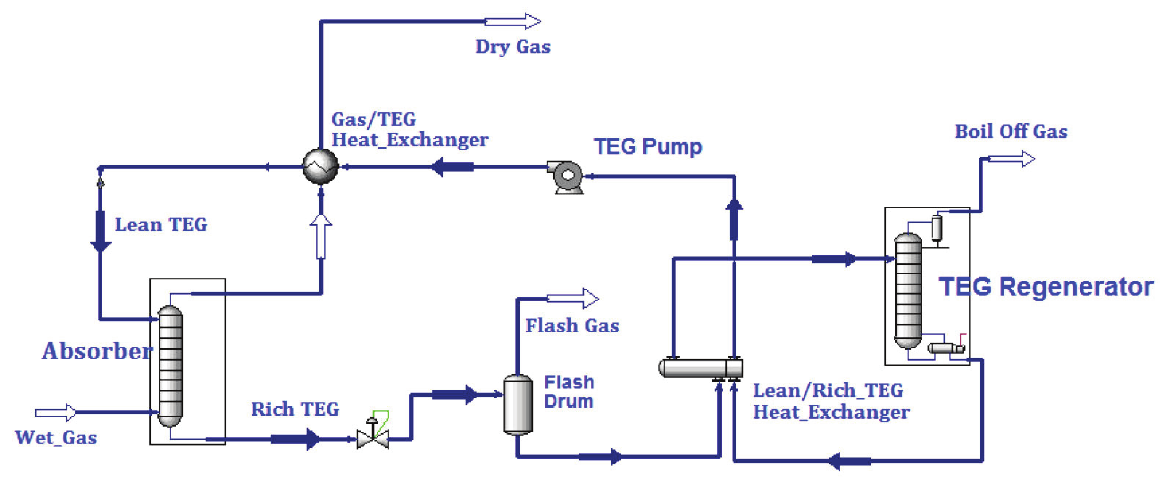
Fig. 1 – Typical TEG dehydration